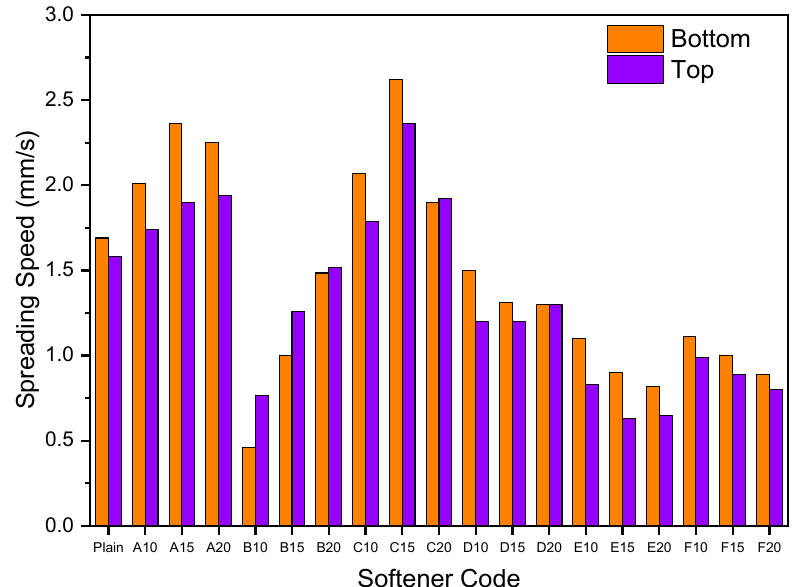
Figure 4. Spreading speed of liquid of the terry knitted fabric with the application of different sof ‐ teners.